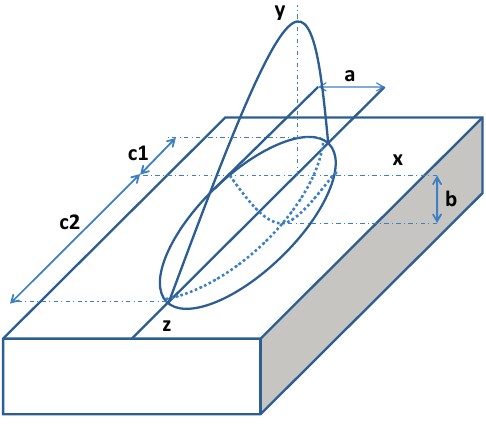
Figure 2. Schematic of double ellipsoidal heat source